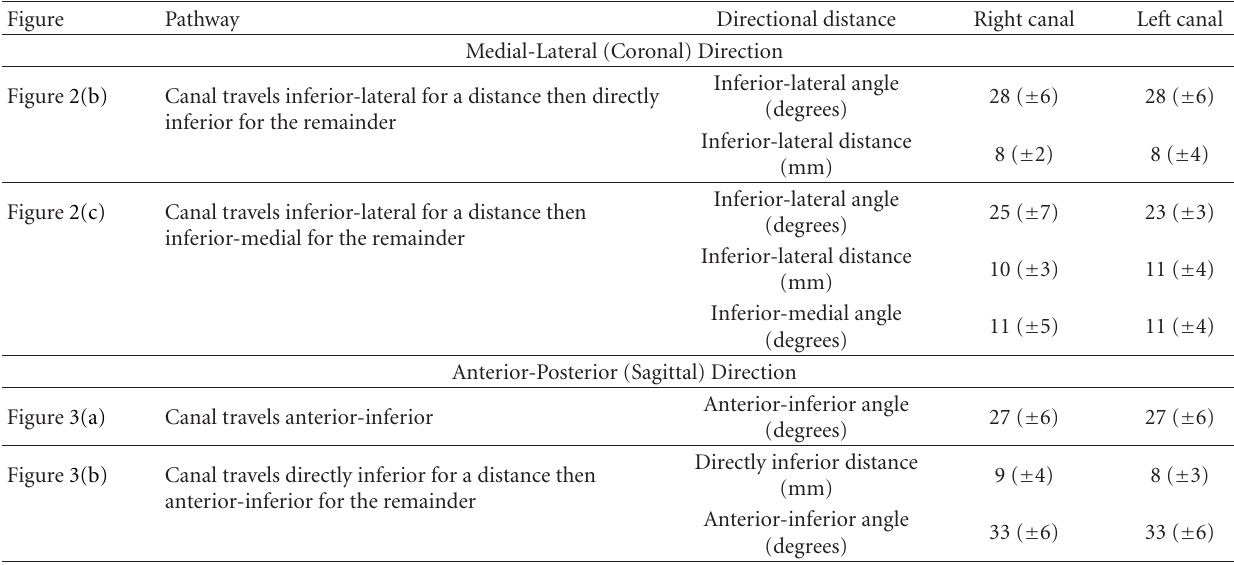
Figure 3(b) Canal travels directly inferior for a distance then anterior-inferior for the remainder